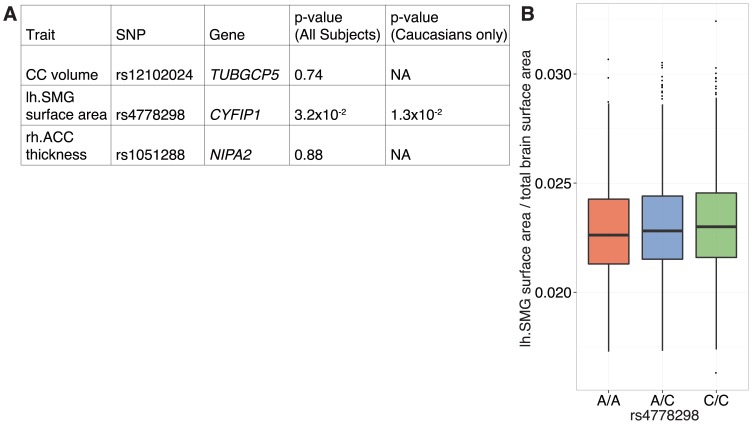
Linear association between common variant genotype at CYFIP1 and surface area across the left supramarginal gyrus (lh.SMG) in an independent cohort.(A) An association between rs4778298 genotype and lh.SMG surface area was observed (pnominal = 3.2x10-2) in a large independent population (n = 1276 for rs12102024 and rs1051288; n = 2621 for rs4778298). Similar to what we observed in our discovery cohort, this effect became stronger on analysis of Caucasian subjects alone and survived correction for multiple comparisons (pnominal = 1.3x10-2; pbonferroni corrected = 4.9x10-2). (B) As in the discovery cohort, a linear relationship between genotype and lh.SMG surface area was observed. Notably, however, directionality was the reverse of what was seen previously. rh.ACC and CC correspond to right anterior cingulate cortex and corpus callosum, respectively.